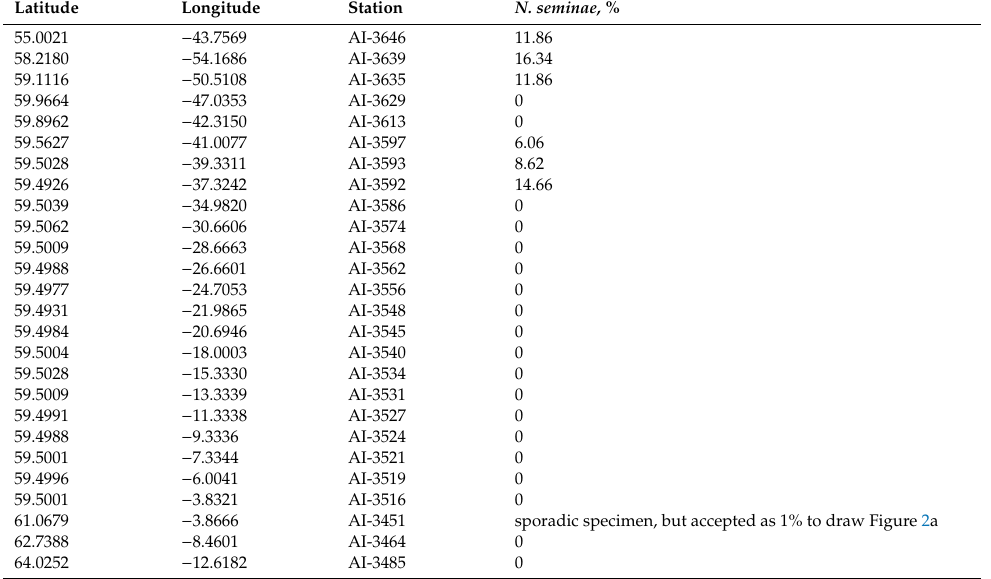
Table A1. Distribution of diatom species Neodenticula seminae in surface sediment samples from the North Atlantic, the 51st cruise of the Russian research vessel Akademik Io ff e in